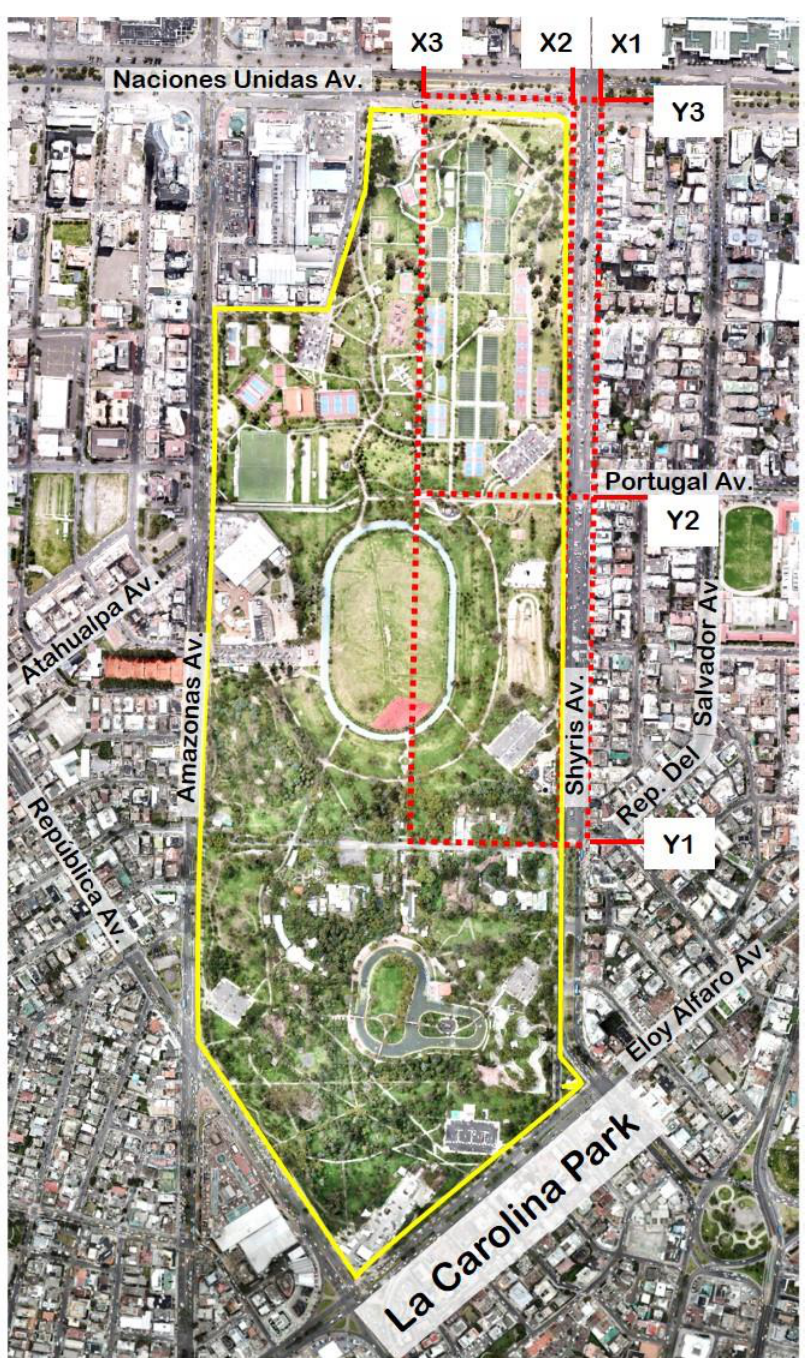
Figure 1. Park and route that was followed to perform the measurements. Urban park: Space delimited by the yellow lines; Route: Red dashed lines.